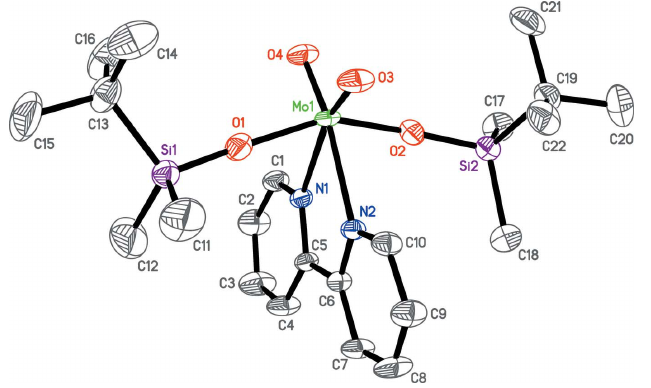
Figure 2 The molecular structure of the title complex (I). Displacement ellipsoids are drawn at the 50% probability level and, for clarity, H atoms have been omitted.